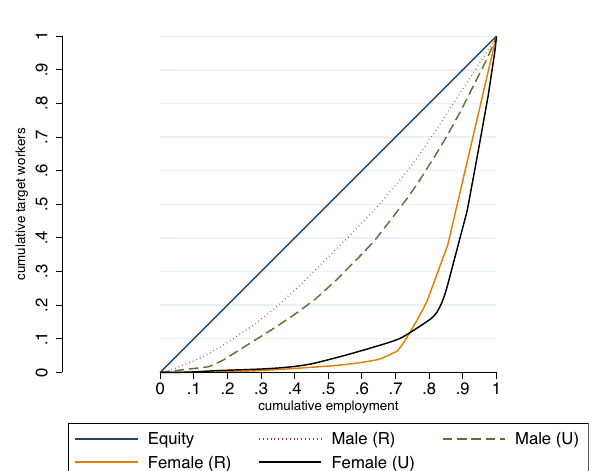
Fig. 2 Occupational segregation curve by gender and region. The fi gure shows the occupational segregation of male and female workers in rural and urban regions.